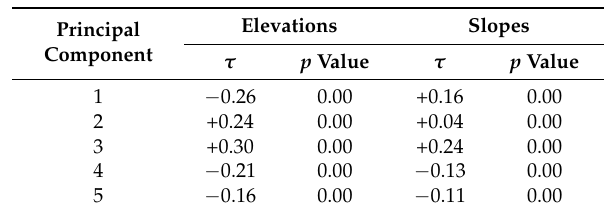
Table 3. Kendall’s rank correlation between the scores of the principal components and elevations or